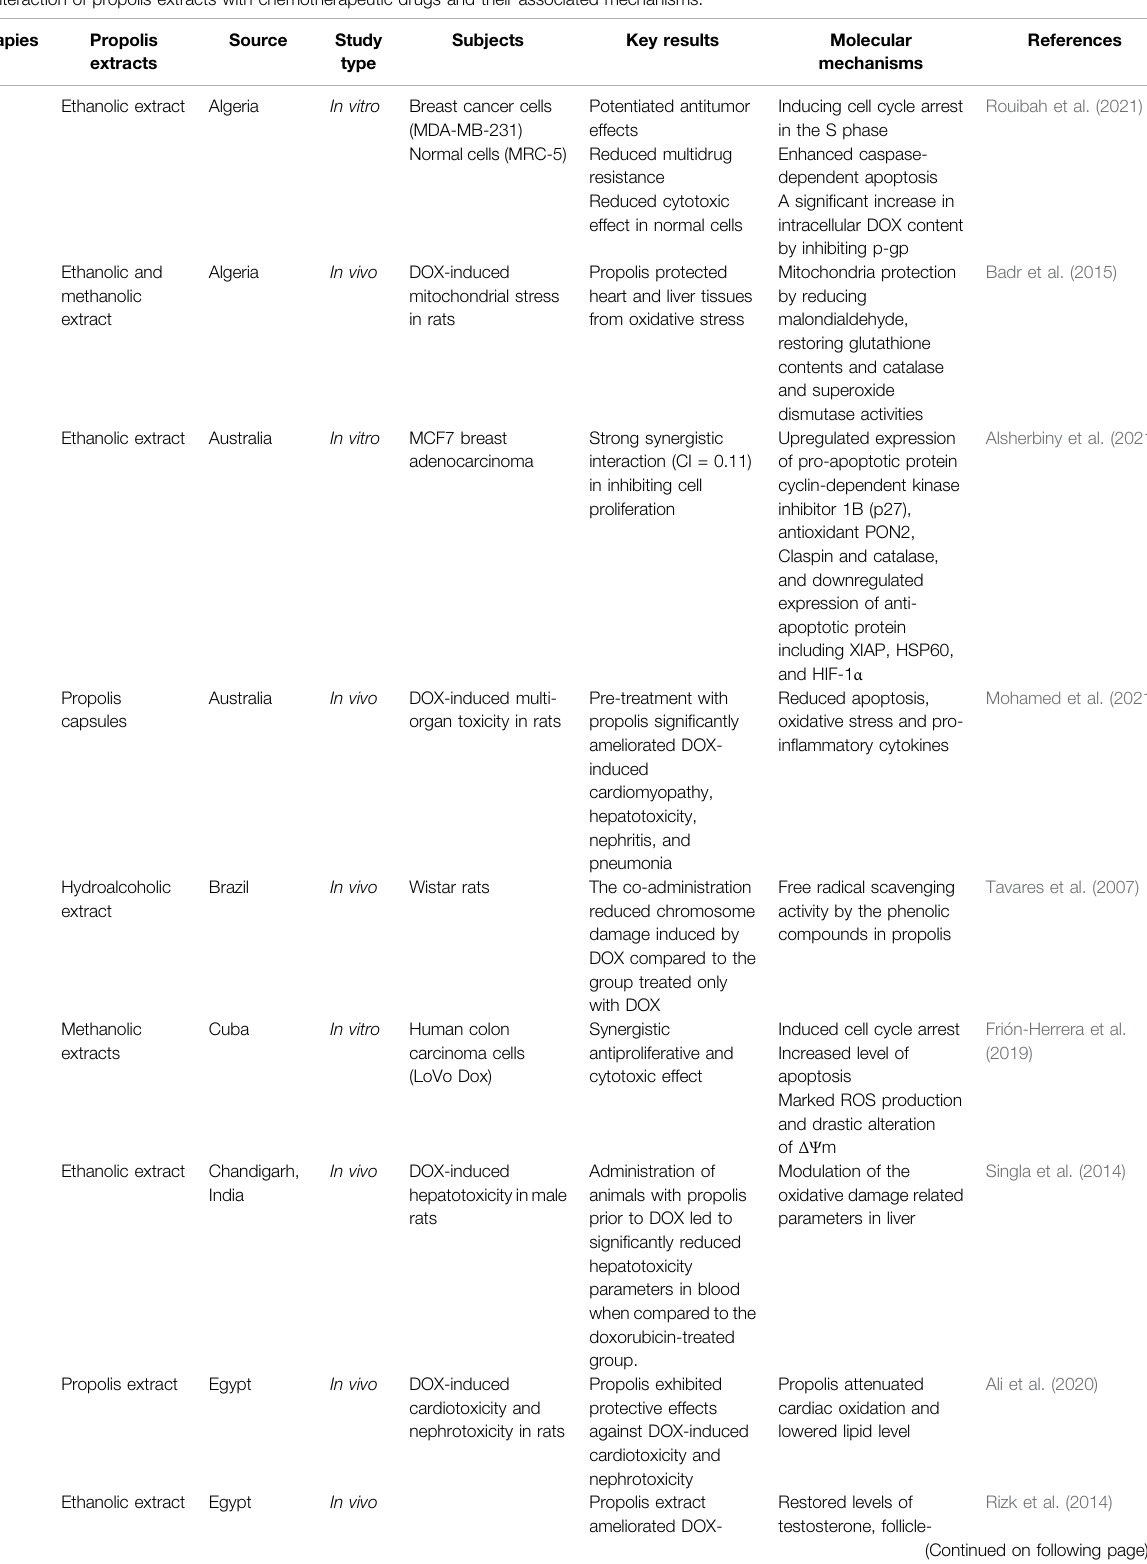
TABLE 1 | Interaction of propolis extracts with chemotherapeutic drugs and their associated